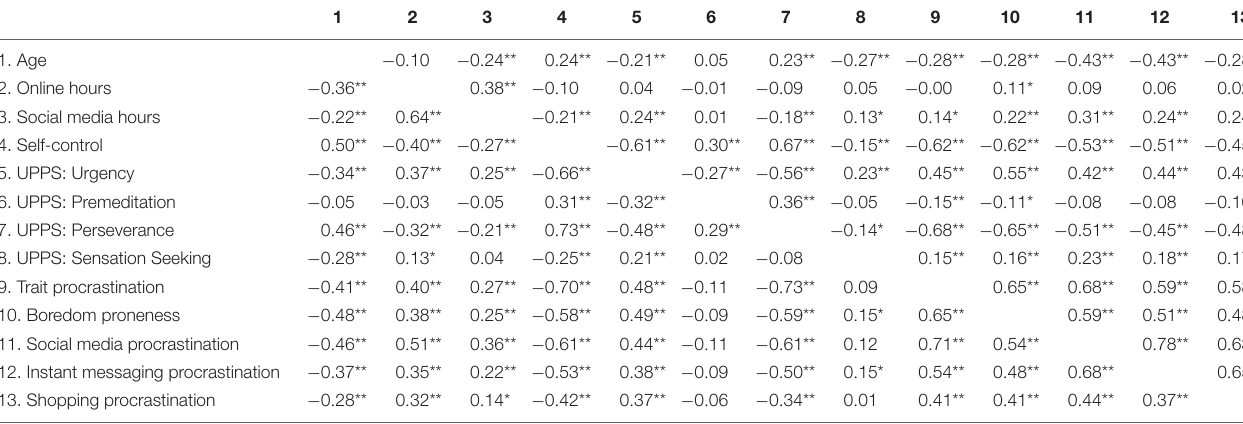
TABLE 3 | Bivariate correlations in the German sample above the diagonal and the Turkish below the diagonal.